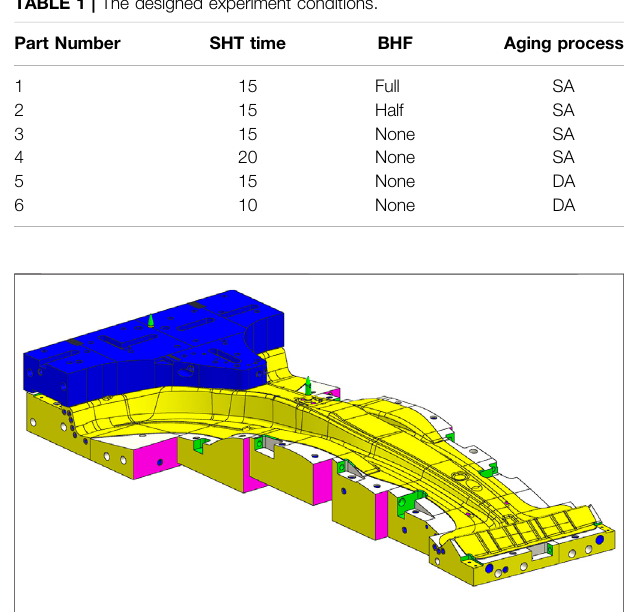
FIGURE 2 | The position of the blank holder.